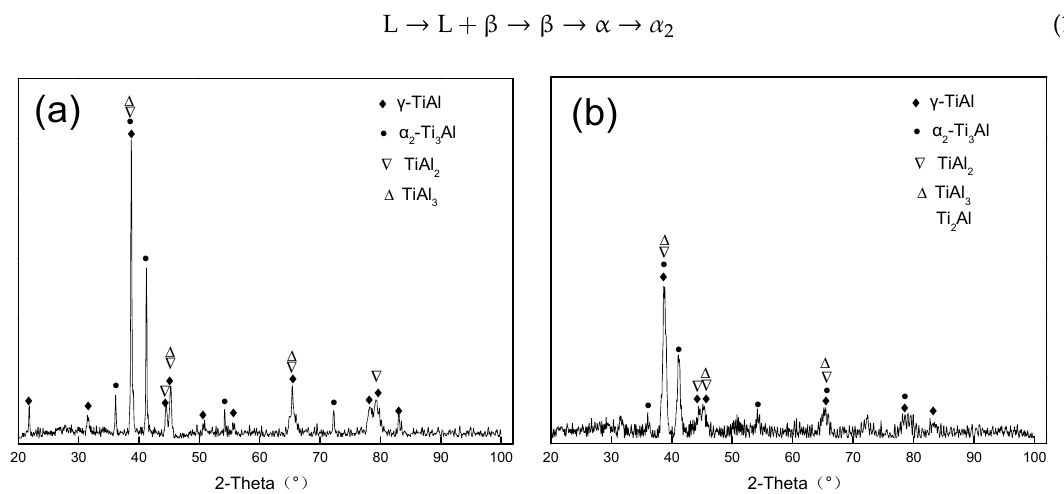
Figure 3. XRD patterns of Ti-48Al-2Cr-8Nb pre-alloyed powder. ( a ) SP powder and ( b ) MP powder.